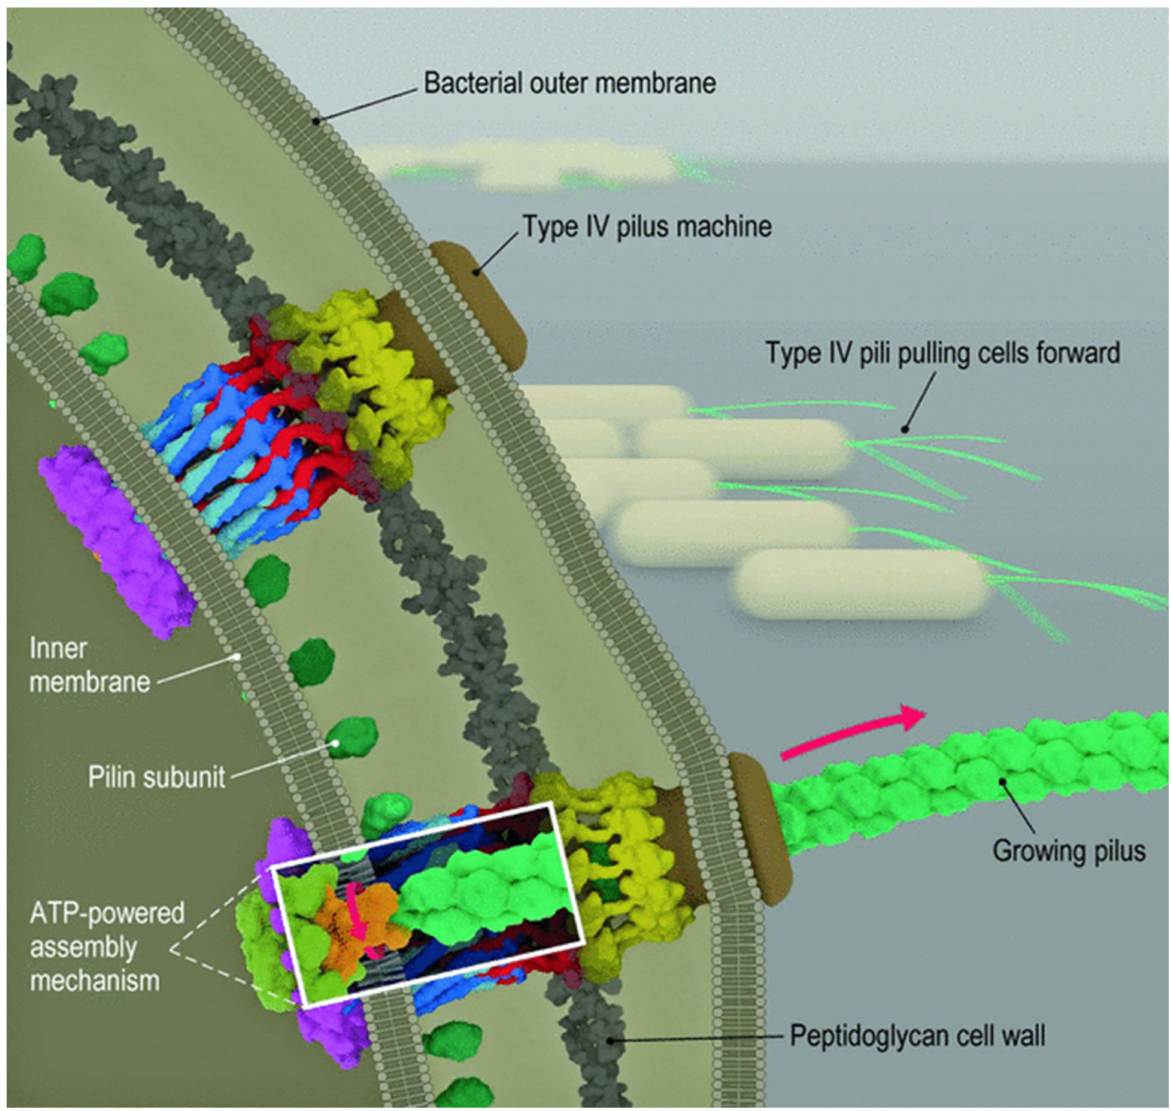
Figure 2. Structure and function of type 4 pili. The addition of peptides to the growing pilus requires ATP for energy. After attachment of the pilus to a surface, retraction of the pilus requires energy provided by ATP. This results in the movement of the bacterium